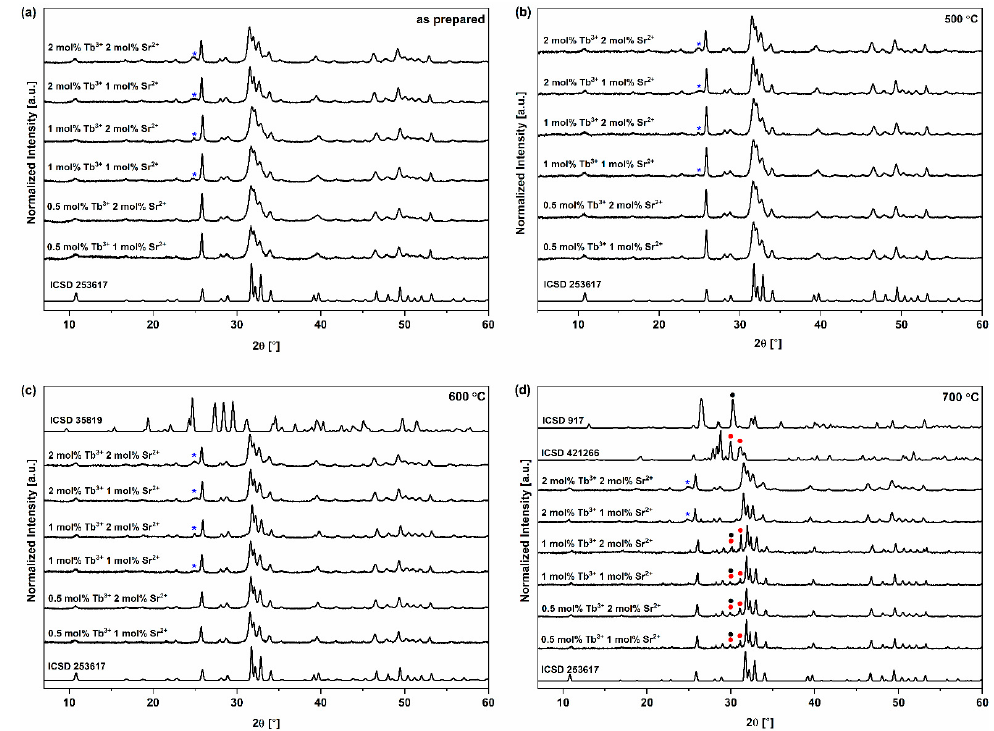
Figure 2. XRD results for the obtained materials: ( a ) not submitted to thermal treatment (as prepared). ( b ) annealed at 500 ◦ C. ( c ) annealed at 600 ◦ C. ( d ) annealed at 700 ◦ C. The hexagonal structure, which is ascribed to the P6 3 /m space group of the HVps, was confirmed for all compounds ( a – d ). ICSD 253617 is database hydroxyapatite pattern. ( * ) indicates peaks originating from SrHPO 4 (ICSD 35819). For the materials annealed at 700 °C ( d ) peaks originating from CaHPO 4 ( ● , ICSD 917) and Ca 2 V 2 O 7 ( ● , ICSD 421266) occur in the range of 26–32°.